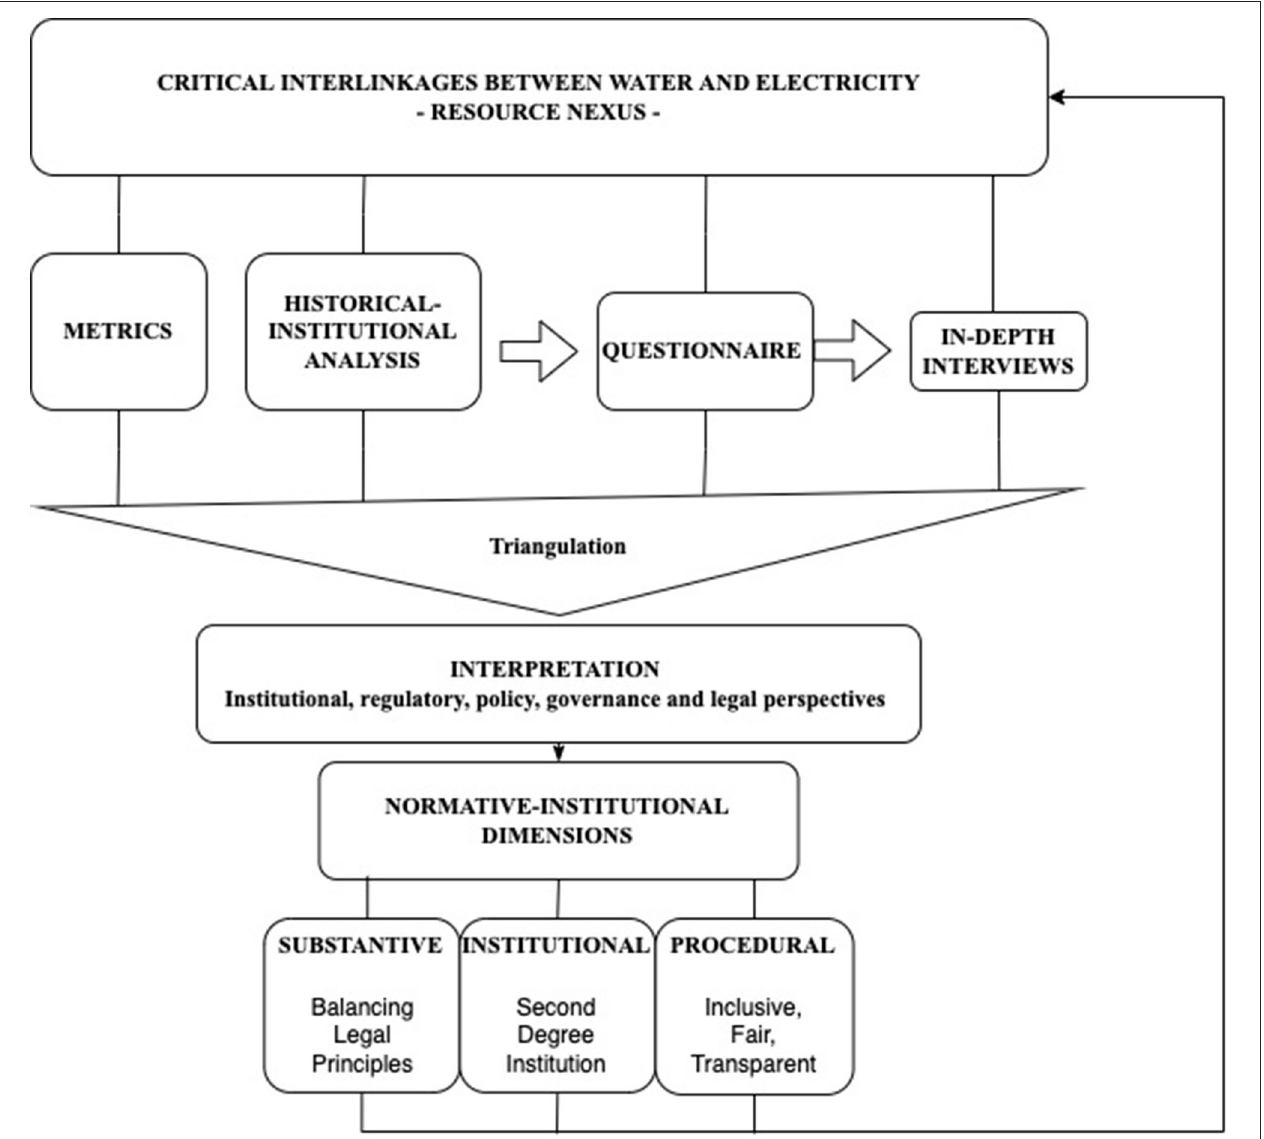
FIGURE 1 | Interdisciplinary methodological approach to assess and address the water-electricity